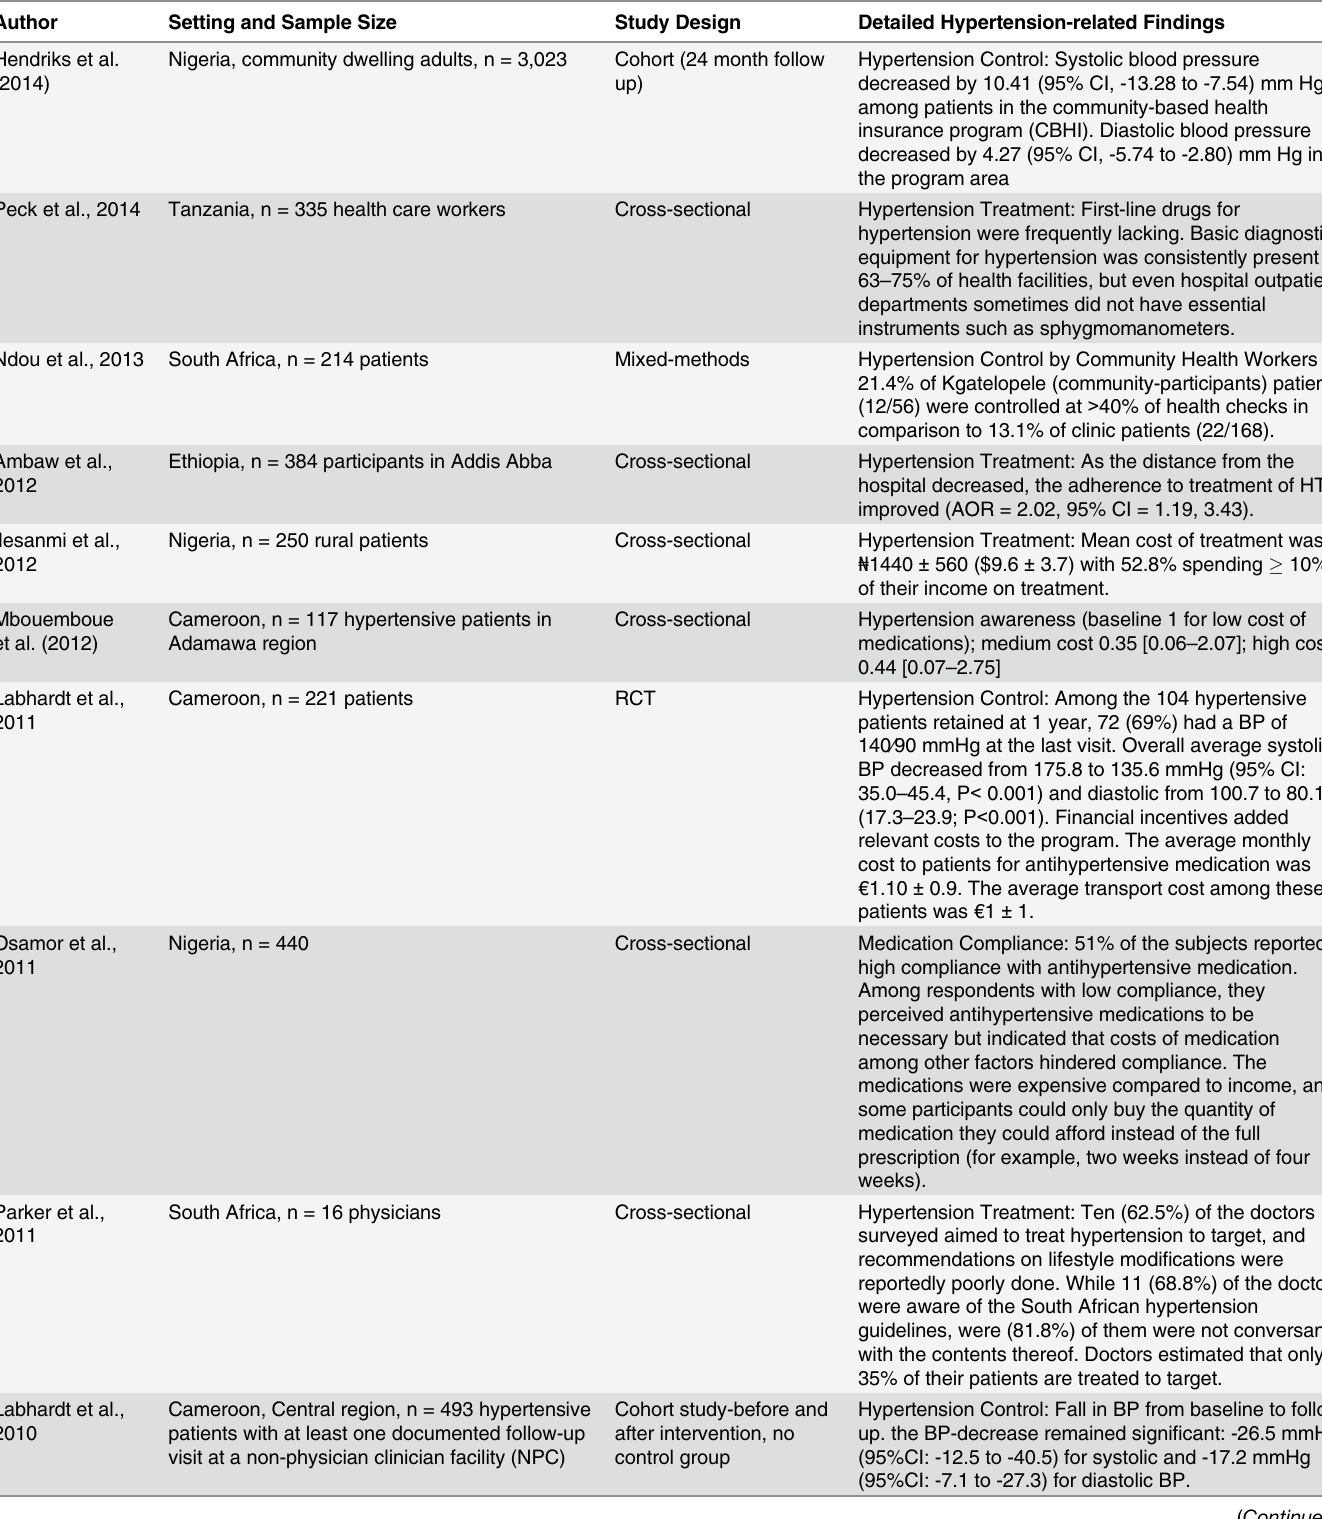
Table 2. Summary of Literature